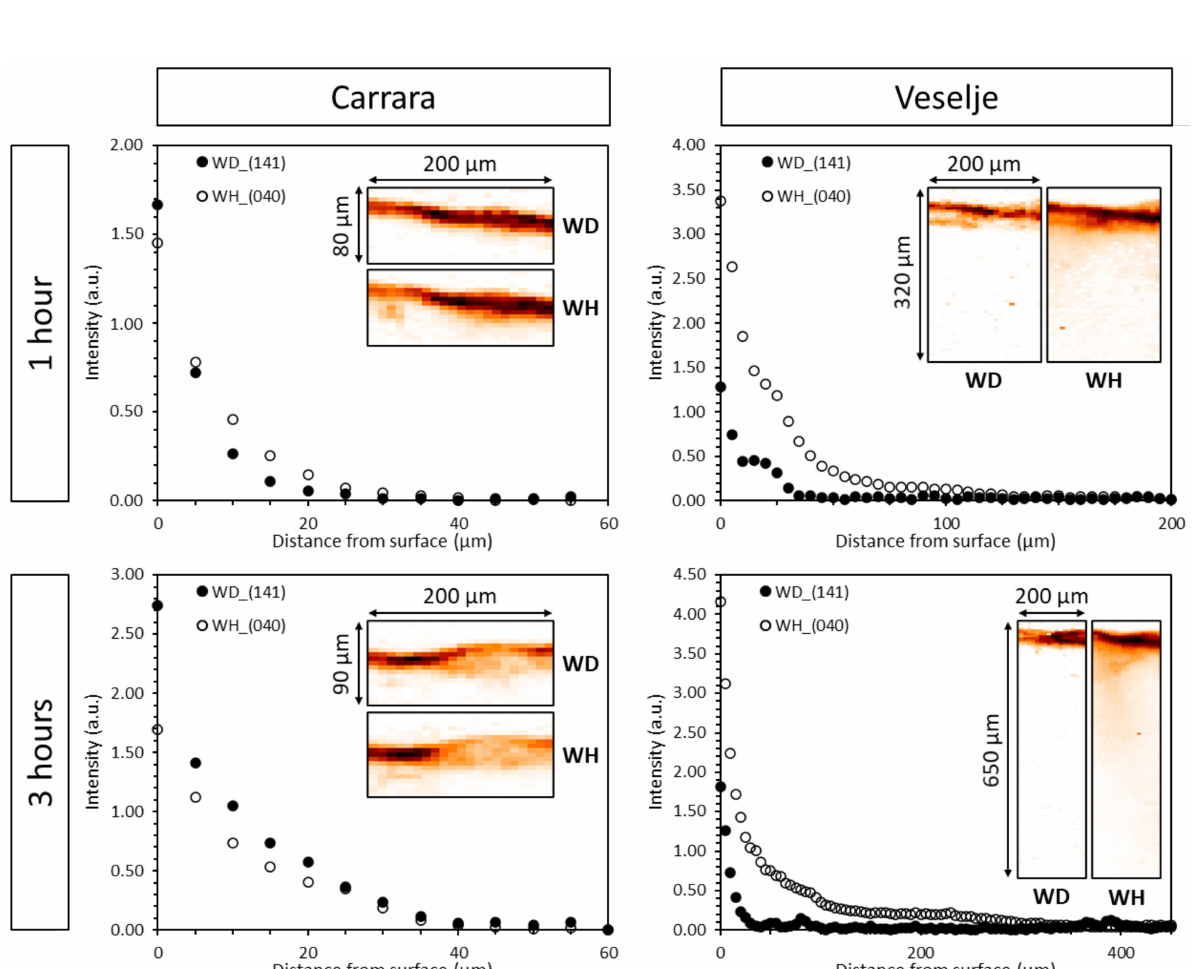
Figure 3. Depth profiles of weddellite (141) and whewellite (040) reflections for Carrara marble ( left ) and Veselje limestone ( right ) for the brushing treatment of 1 h ( top ) and 3 h ( bottom ). These profiles are the averaged results over the entire map (21 lines). The corresponding distribution maps of weddellite and whewellite are shown as insets in each graph. The darker color indicates a higher oxalate intensity at the top of the